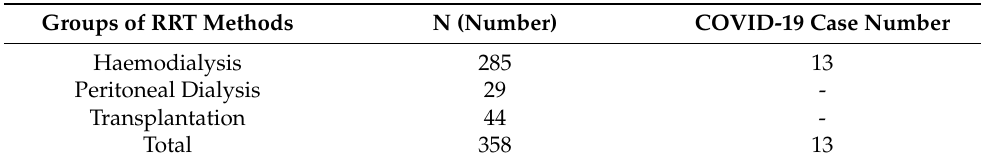
Table 3. Number of COVID-19 cases detected in patients receiving haemodialysis between